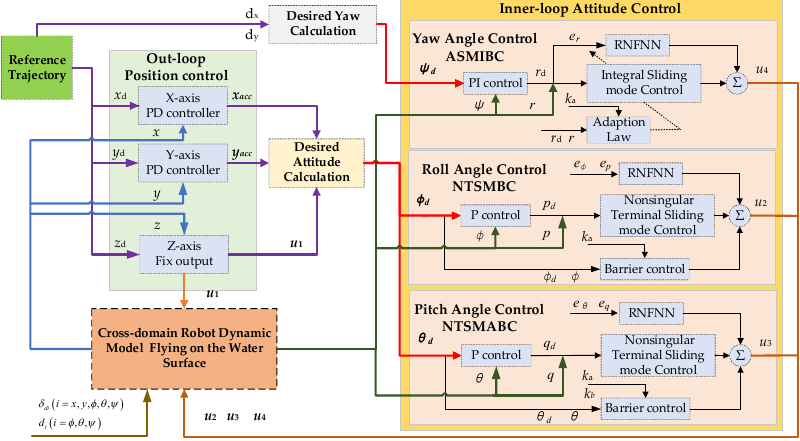
Figure 6. The control block diagram of the robot flying on the water surface.